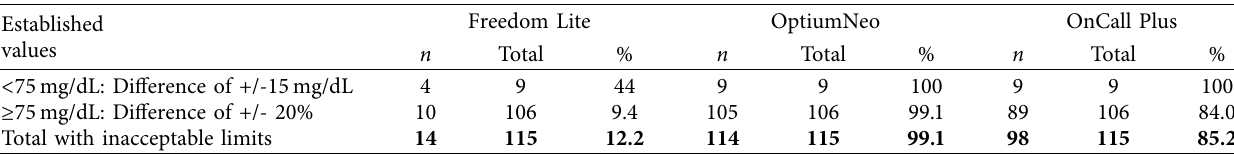
Figure 5: Passing-Bablok regression for the On Call plus ® Table 4: Percentage and absolute values of blood glucose concentration obtained using the three glucometers, according to the ISO 15197: 2003 standards in dogs.